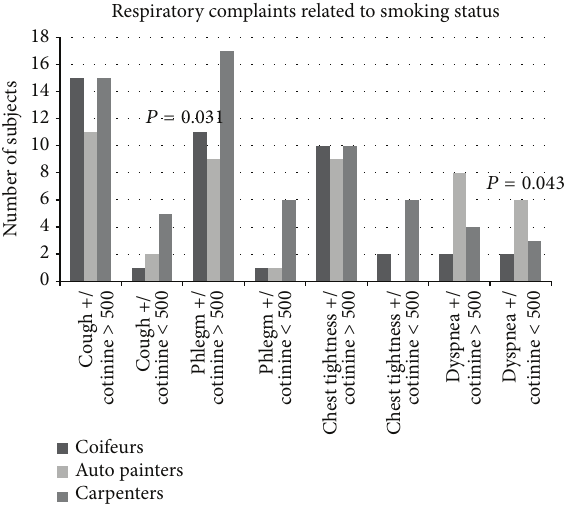
Figure 1: Relationship between number of workers and respiratory symptoms related to smoking (Chi-square test was used to compare the rates of complaints of